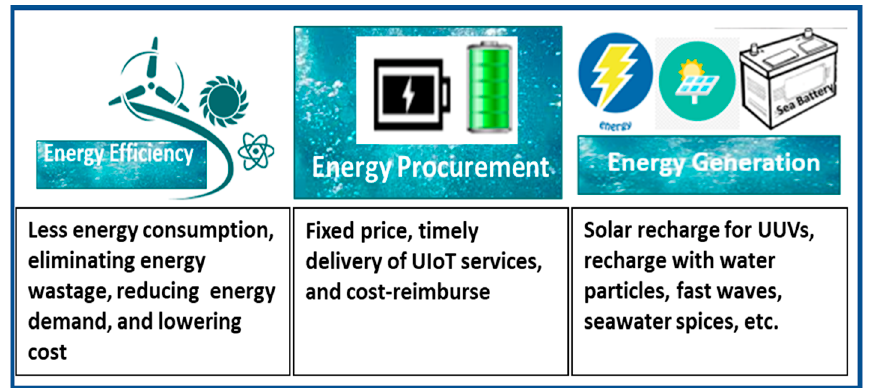
Figure 2. Energy optimization in UIoT .